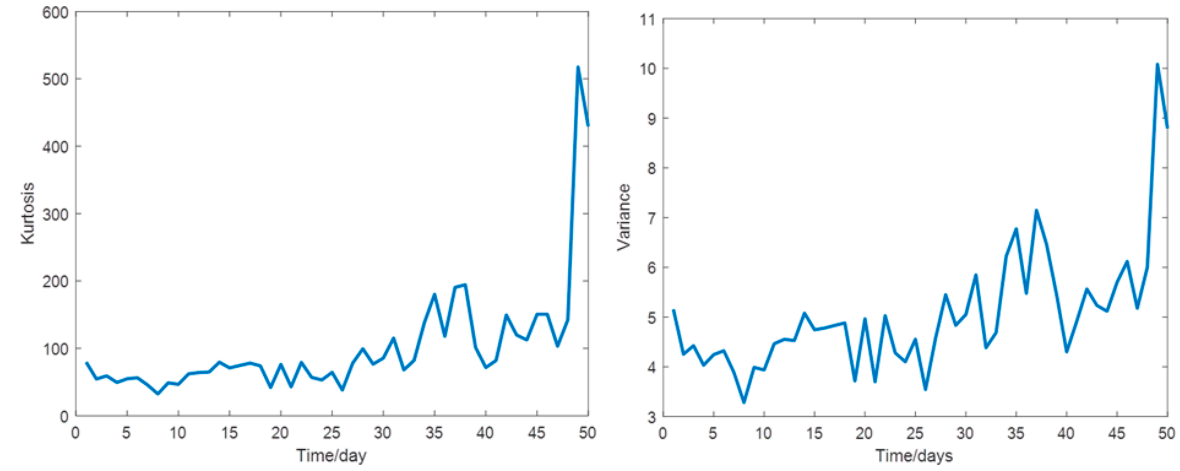
Figure 5. Two time-domain features over the 50 days of vibration signals [30].